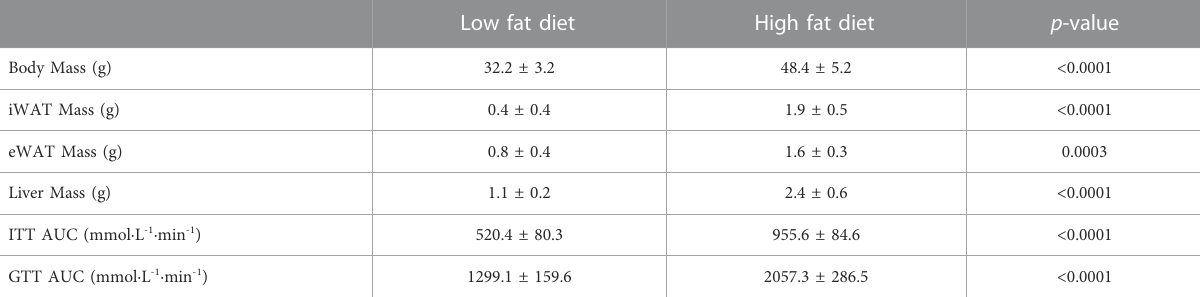
TABLE1Differencesbetweenthelowfatandhighfatdietgroupsinbodymass,tissuenecropsy,andinsulinsensitivitymeasuresfollowing8 weeksofdietary